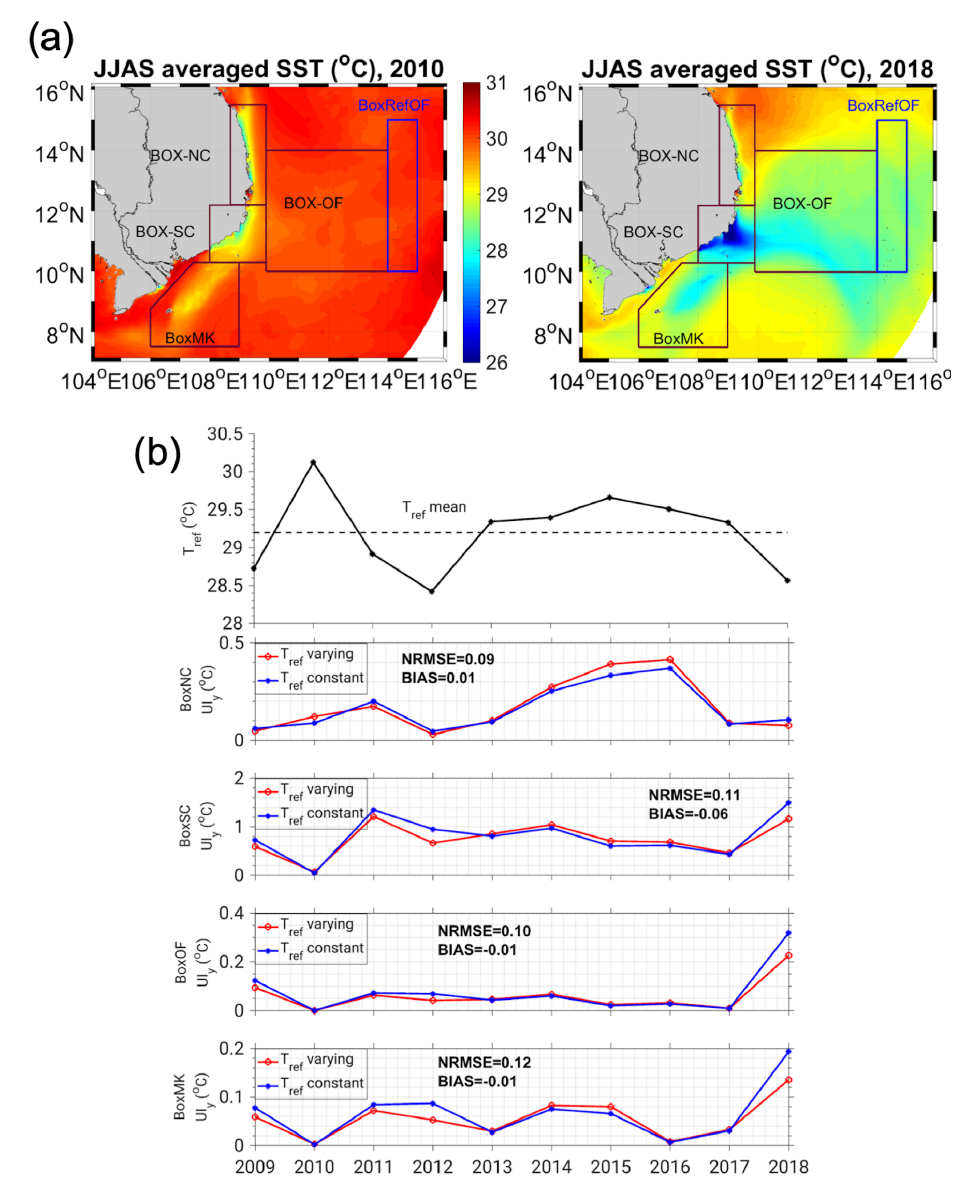
Figure 17. (a) Maps of JJAS-averaged SST in 2010 and 2018 in the 2009–2018 simulation ( ◦ C). Panel (b) (first row): yearly time series of the JJAS-averaged SST over the reference box for each year (i.e., varying T ref , full black line). The dashed line shows the value of the climatological summer-averaged SST over the reference box (i.e., constant T ref ). Panel (b) (second to fifth row): yearly time series of upwelling indexes UI y computed using a varying (red) vs. constant (blue) T ref for BoxNC, BoxSC, BoxOF, and